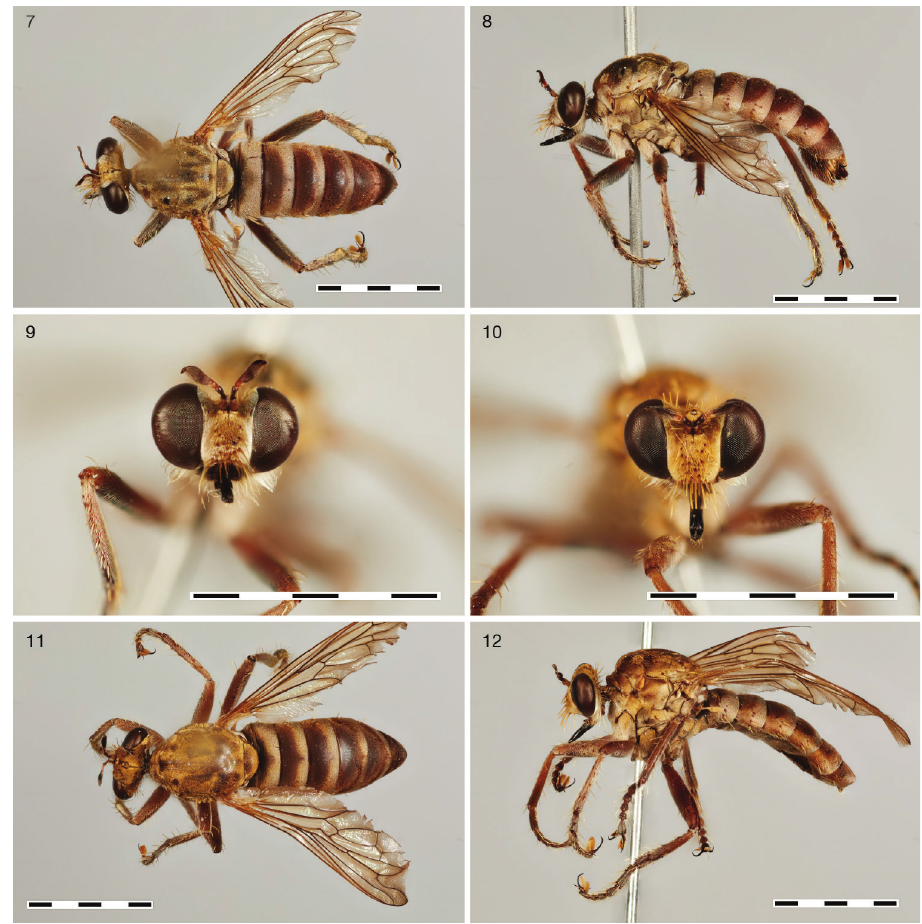
Figures 7–12. Laphyctis argenteofasciata : ♂ (USNMENT01088130) 7 dorsal (Morphbank #861210) 8 same, lateral (#861212) 9 same, head anterior (#861214), ♀ (USNMENT01088126) 10 head anterior (#861222) 11 same, dorsal (#861218) 12 same, lateral (#861220). Scale = 5